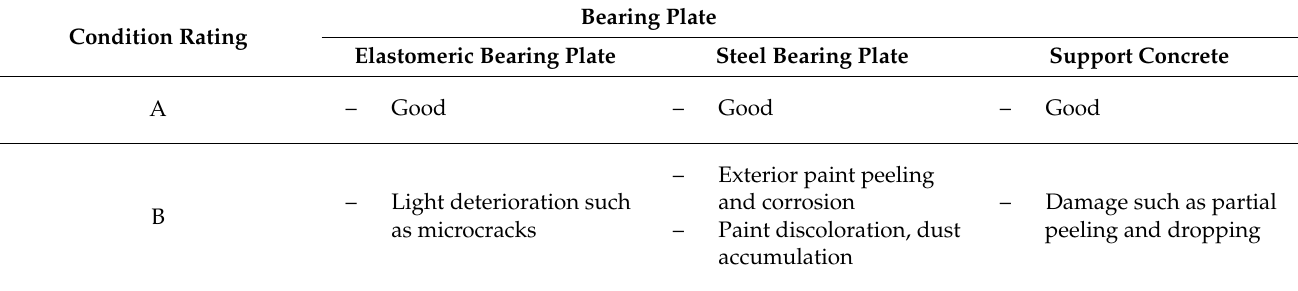
Table 4. Condition grading system for bearing